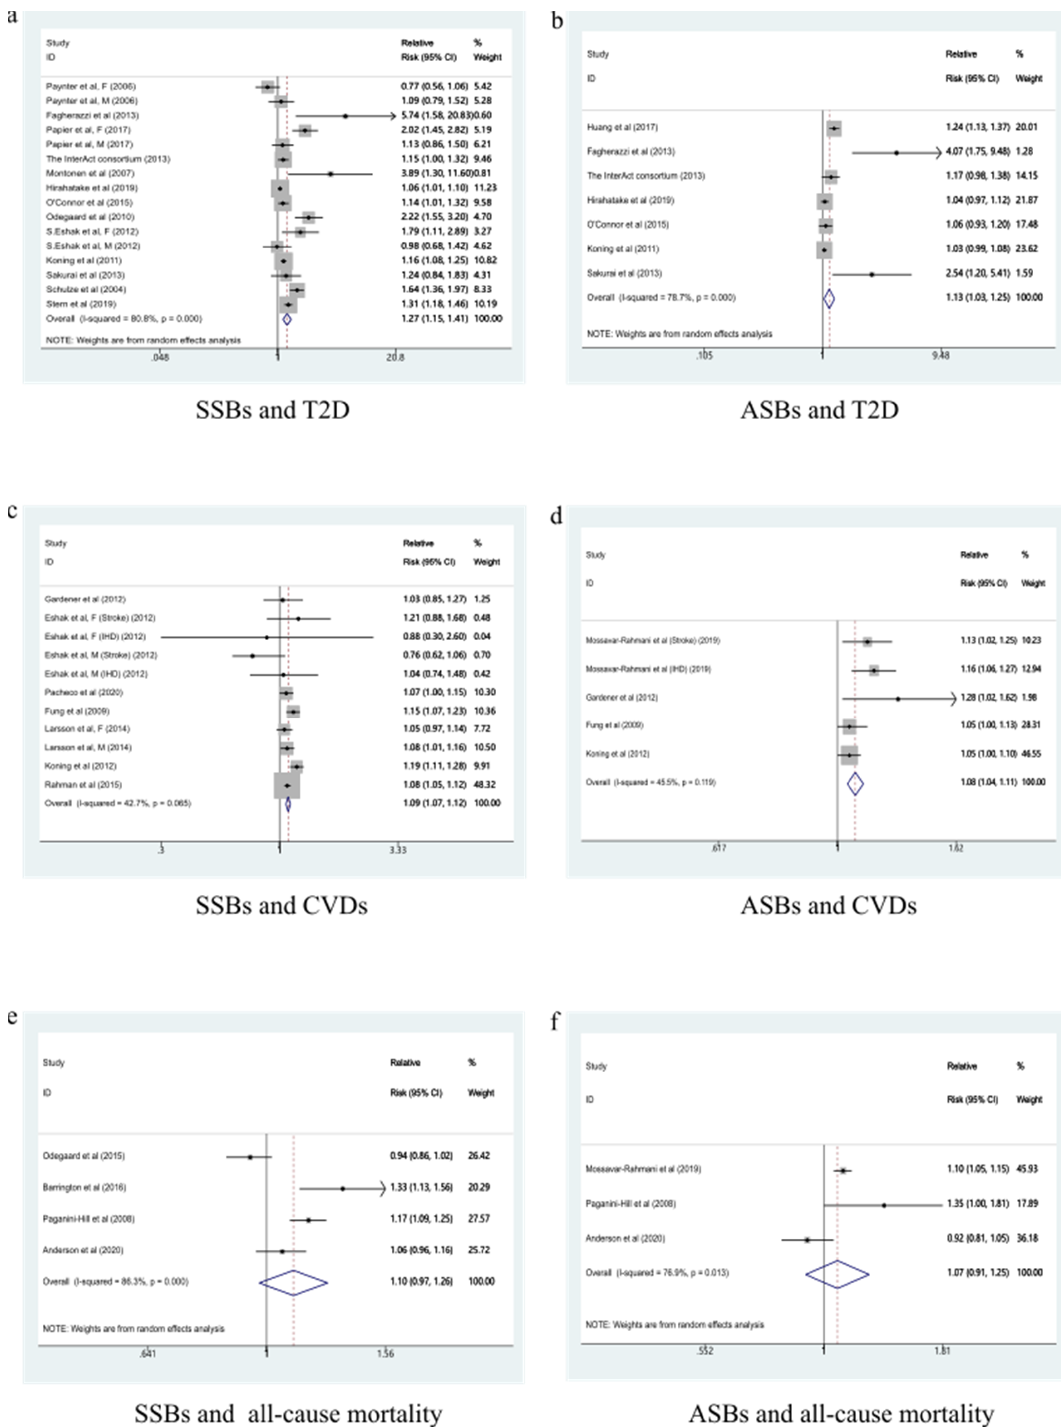
Figure 4. Forest plot of RR for each additional SSB and ASB serving per day and the risk of type 2 diabetes, cardiovascular diseases, and all-cause mortality. ( a ) Forest plot of RR for each additional SSB serving per day and the risk of T2D. ( b ) Forest plot of RR for each additional ASB serving per day and the risk of T2D. ( c ) Forest plot of RR for each additional SSB serving per day and the risk of CVDs. ( d ) Forest plot of RR for each additional ASB serving per day and the risk of CVDs. ( e ) Forest plot of RR for each additional SSB serving per day and the risk of all-cause mortality. ( f ) Forest plot of RR for each additional ASB serving per day and the risk of all-cause mortality. SSBs, sugar-sweetened beverages; ASBs, artificially sweetened beverages; T2D, type 2 diabetes; CVDs, cardiovascular diseases.